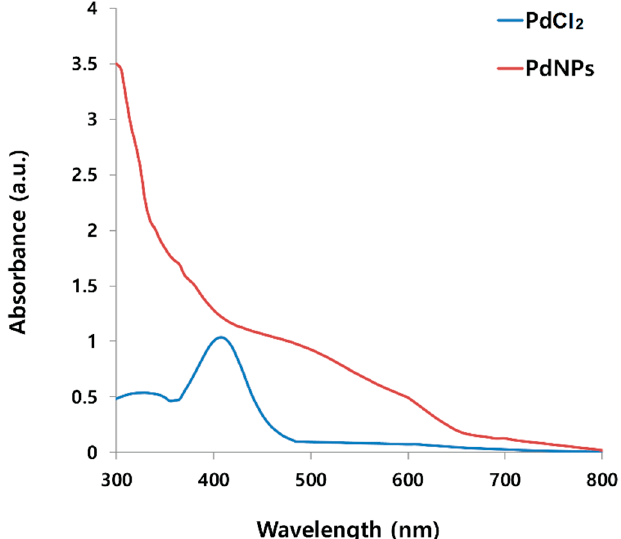
Figure 1. Ultraviolet-Vis (UV-Vis) spectra of aqueous palladium chloride (PdCl 2 ) solution and Pd nanoparticles (PdNPs) prepared using leaf extract of Evolvulus alsinoides . UV-Vis spectrum of reference sample PdCl 2 showed a peak at 417 nm due to absorption of Pd(II) ions. For reduced samples, the peak at 417 nm was absent and a broad continuous absorption was observed, indicating formation of PdNPs.